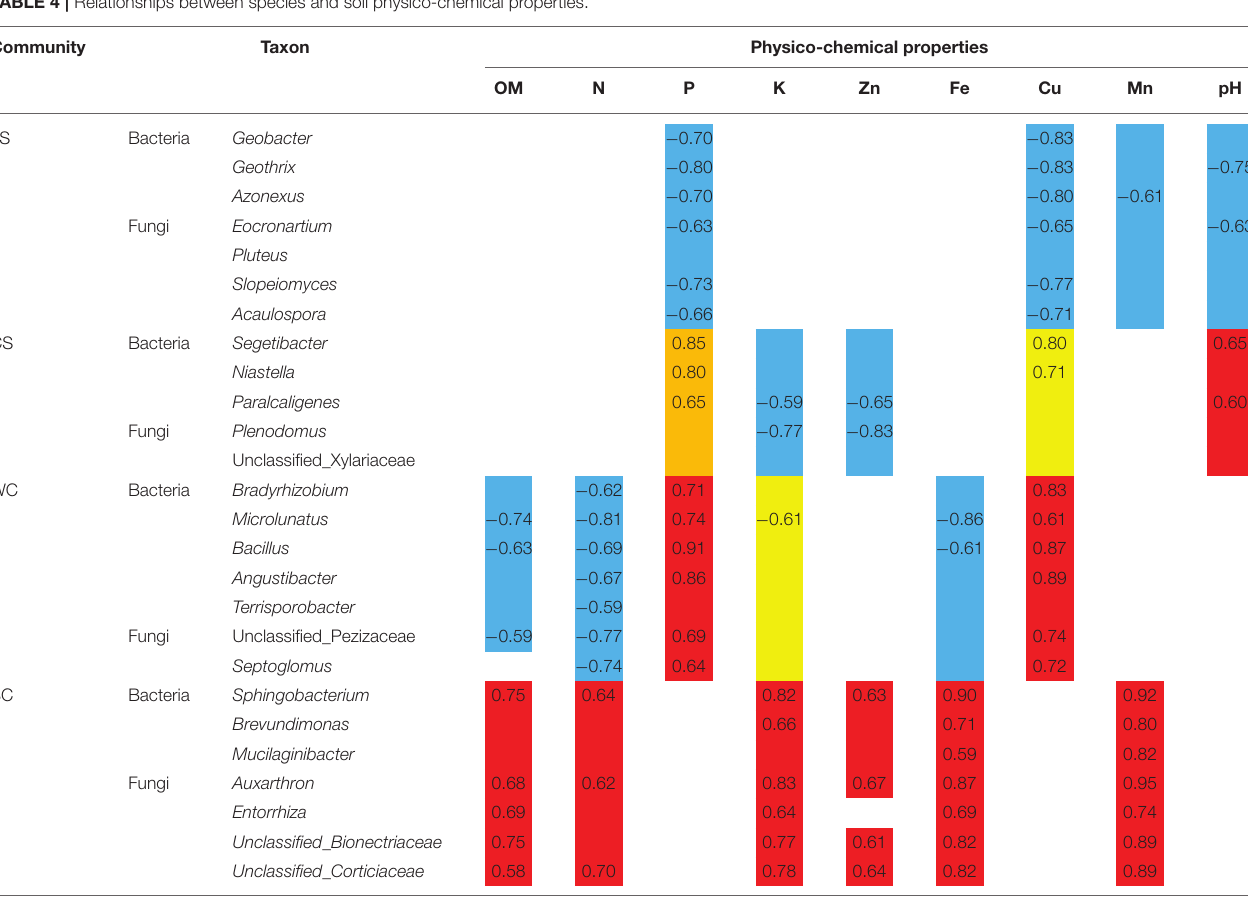
FIGURE 3 | English letters in the image on the right are represented in each group and play an important role in the outline of the species name level. The names on the outer ring of the letters between groups play an important role in the door at the species name level; thus, each layer of nodes from the inside runs through the phylum, class, order, family, genus, and species. Each species layer represents the process from inside extroversion to the said phylum, class, order, family, genus, and species. The diameter of the node is proportional to the relative abundance. SC, soybean continuous cropping system; FS, fallow-soybean cropping system; CS,